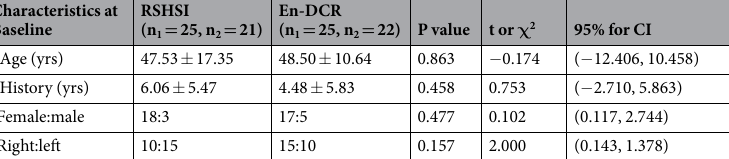
Table 2. Baseline Characteristics of patients in the Analysis. Note: * Two-tailed independent t test. # Two-tailed chi-square test. Abbreviations: RSHSI, Recessive Spherical Headed Silicone Intubation. En-DCR, Endonasal Dacryocystorhinostomy. CI, Confidence Interval. n 1 = the number of operative eyes in each group. Right: left was analysed based on n 1 . n 2 = the number of NLDO patients in each group. Age, history and gender were analysed based on